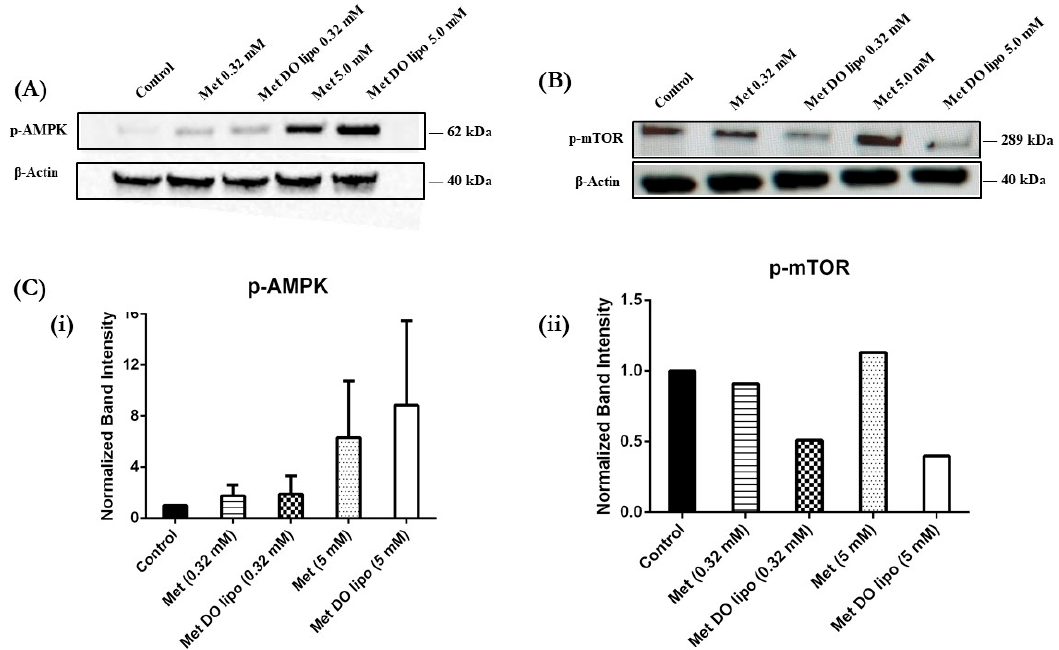
Figure 9. Effect of treatment on cellular markers representing anti-tumor activity. ( A ) Representative Western blots to understand the effect of treatments on p-AMPK activity after 24 h of treatment at varied concentration. ( B ) Representative Western blots to understand the effect of treatments on p-mTOR activity after 24 h of treatment at varied concentration. ( C ) Representative quantified analysis of p-AMPK and p-mTOR (normalized) band intensity determined using ImageJ. As can be seen, Met DO lipo displays increased activation of p-AMPK (increased band intensity) and inhibition of p-mTOR (diminished band intensity) as compared to Met. The effect was seen to be concentration dependent. Representative images from n = 1 (for p-mTOR) to two (for p-AMPK) experiments.